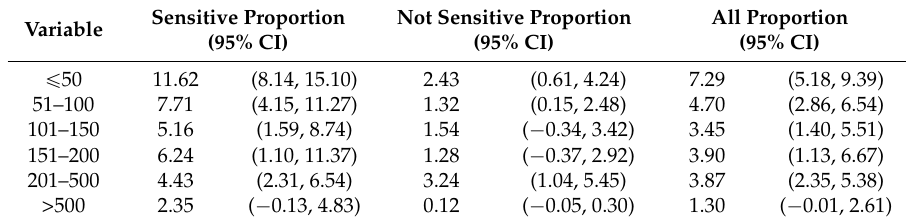
Table A9. Distance to major roads proportions of sleep disturbance due to road traffic in the weighted study sample, adjusted for sensitivity to noise: marginal prediction by sensitivity.